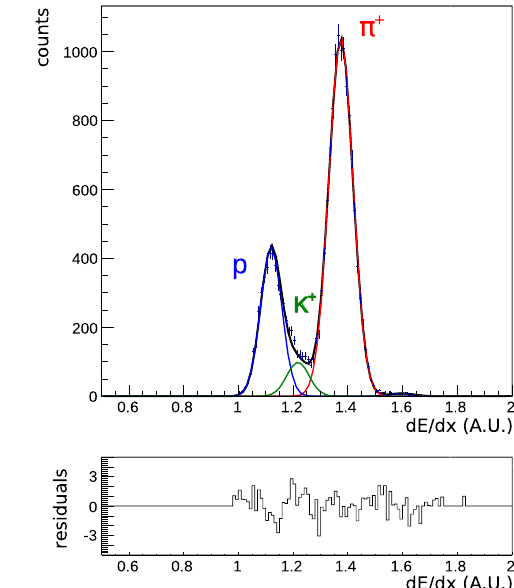
types is shown by solid lines. The corresponding residuals (the differ- ence between the data and fit divided by the statistical uncertainty of the data) is shown in the bottom plots